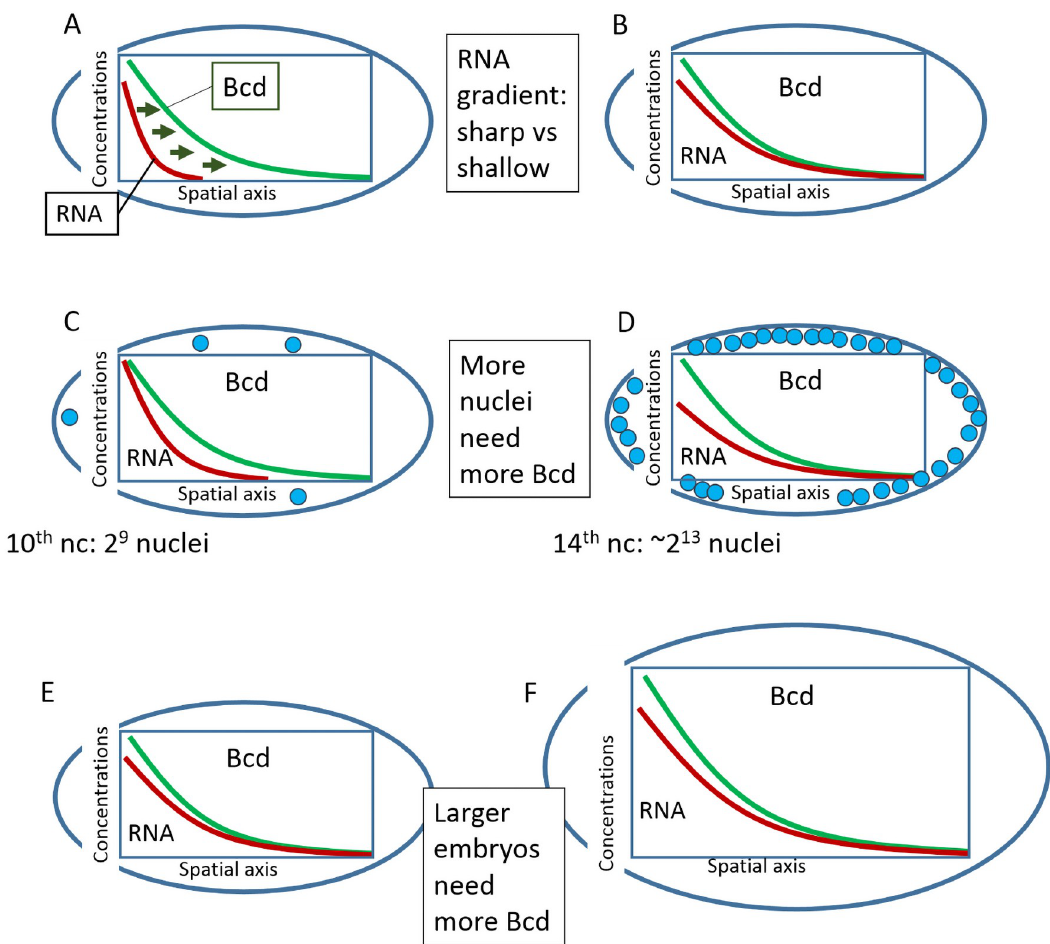
Fig 1. Some open problems regarding the production area of Bcd protein in the early embryo. A-B. The more extended the Bcd production area, the lower the Bcd diffusivity needs to be. Short sources require fast diffusion for the Bcd molecules to form the morphogenetic gradient (A), while an extended source makes the gradient less dependent on fast Bcd diffusion (B). C-D. An adaptable Bcd production area could compensate for required changes in Bcd production. Bcd is mainly sequestered by nuclei, so nucleus doubling in each cycle could require more total Bcd, or higher Bcd production. E-F. Large embryos should have more extended and powerful Bcd production